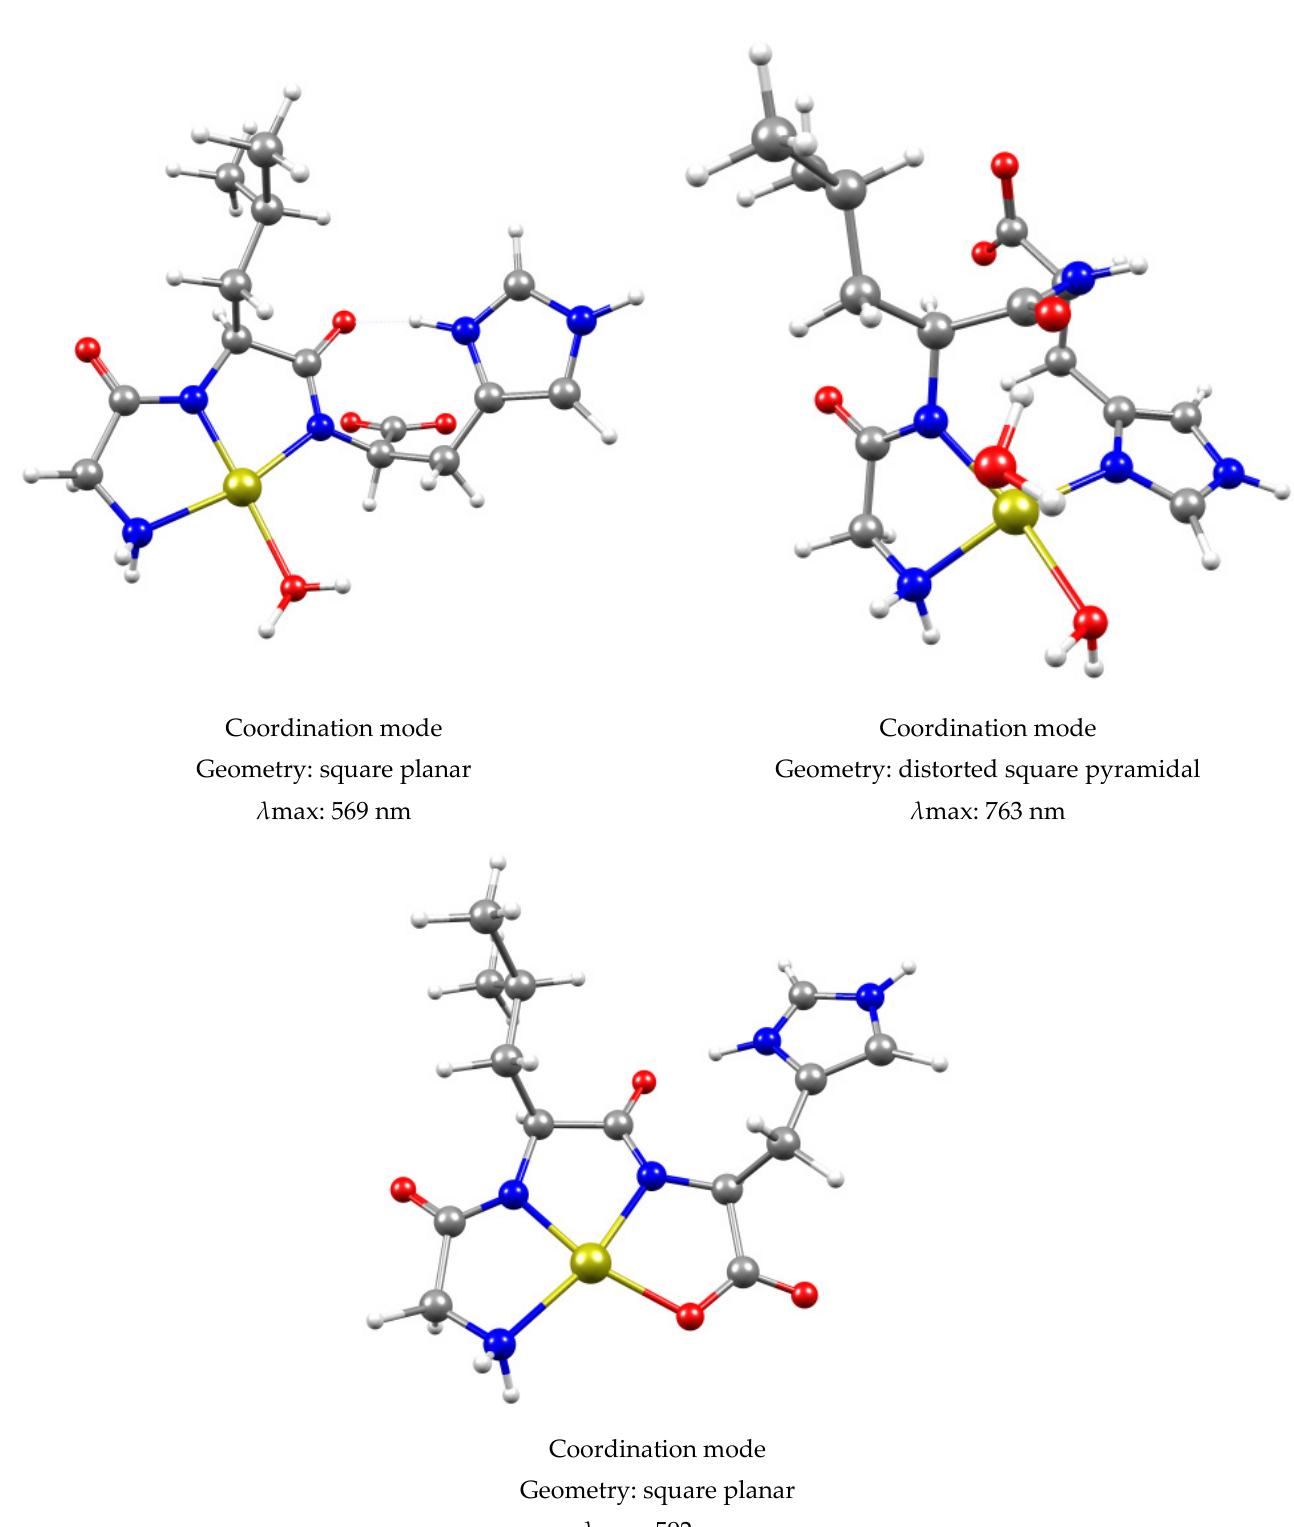
Figure 14. Visual representation of the proposed structures for the MLH –1 species of Cu-GLH, as well as their geometries and calculated λ max obtained at B3LYP/6-31++G ** in water.